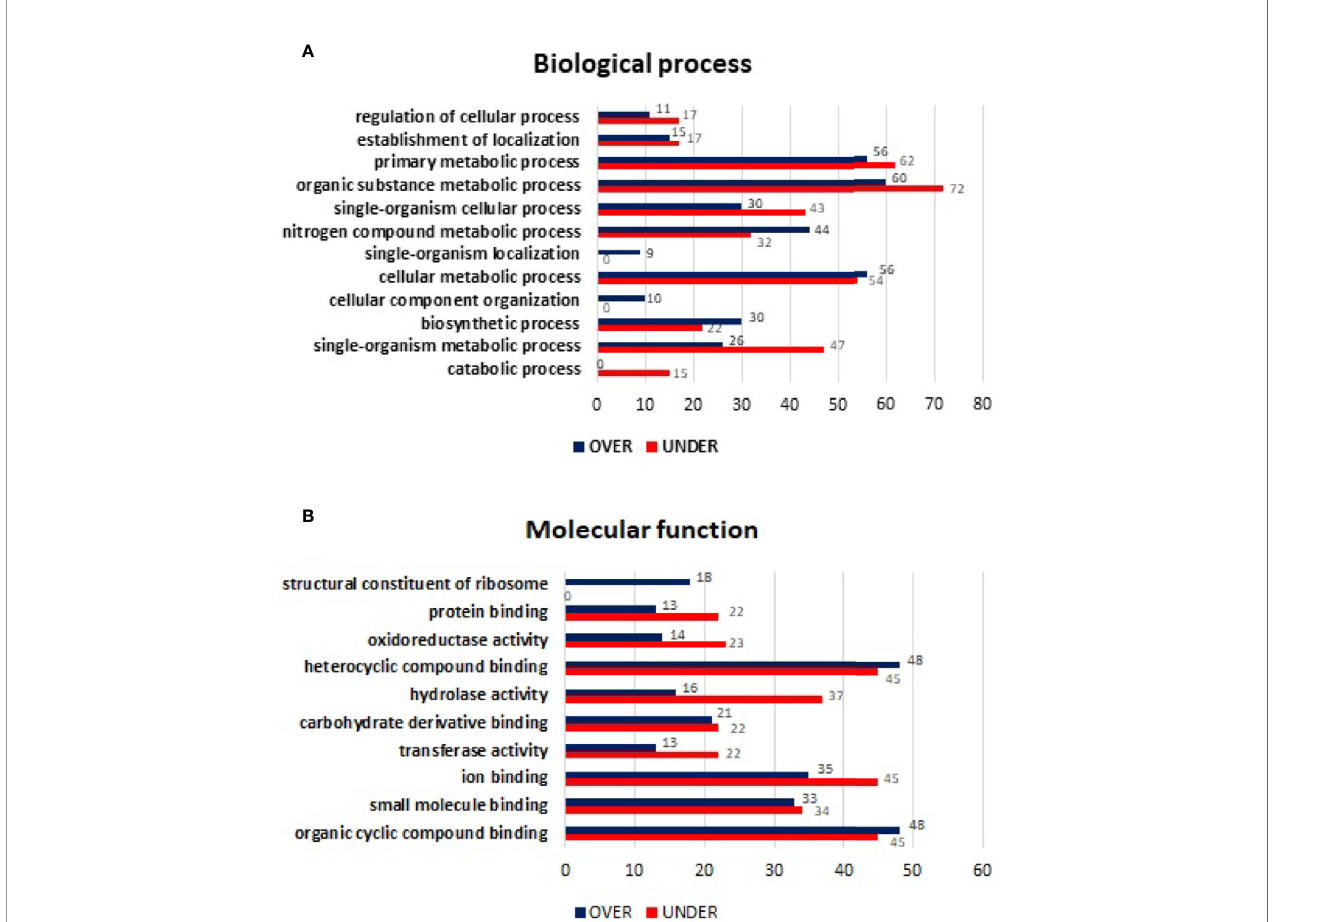
FIGURE 6 | Gene ontology of differentially represented proteins from salivary glands of R. sanguineus tropical lineage vs. R. sanguineus temperate lineage identi fi ed only in the infection condition. GO terms and its representation of biological process (A) , and molecular function (B) obtained using level 3. Blue bars represent the number of over-represented proteins in the tropical lineage compared to the temperate lineage and red bars represented the number of under-represented proteins in the tropical lineage compared to the temperate lineage (can be interpreted as the number of proteins more represented in the temperate lineage compared to the tropical lineage), with statistical signi fi cance ( p <